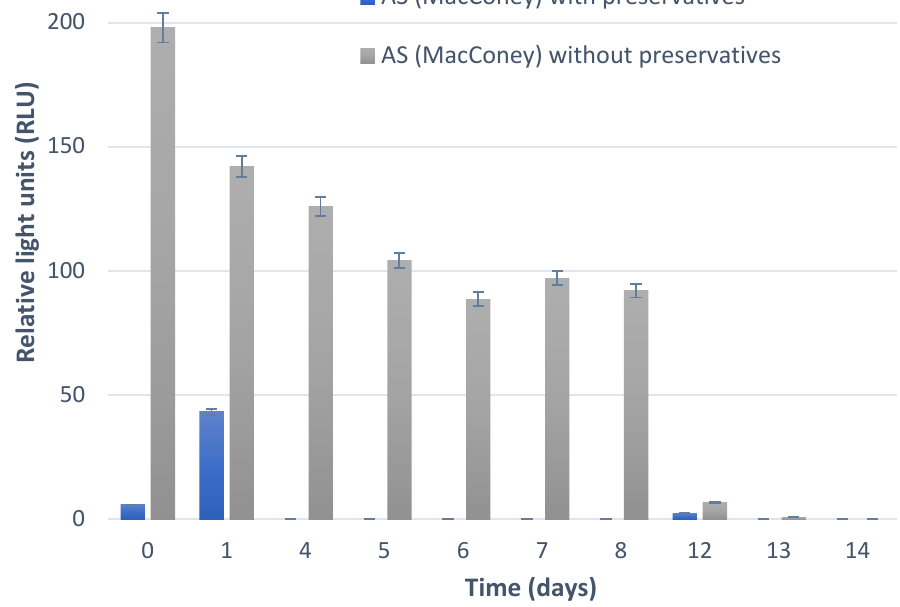
Figure 2. RLU mean values of aubergine salad (AS) with and without preservatives in relation to storage time, after incubation in MacConkey broth for 24 h at 35 °C.